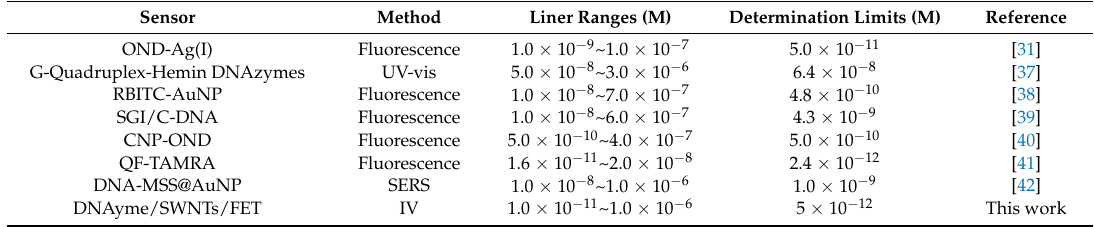
Table 1. Comparison the parameters of the prepared biosensor with other sensors for Ag(II) detection. Sensor